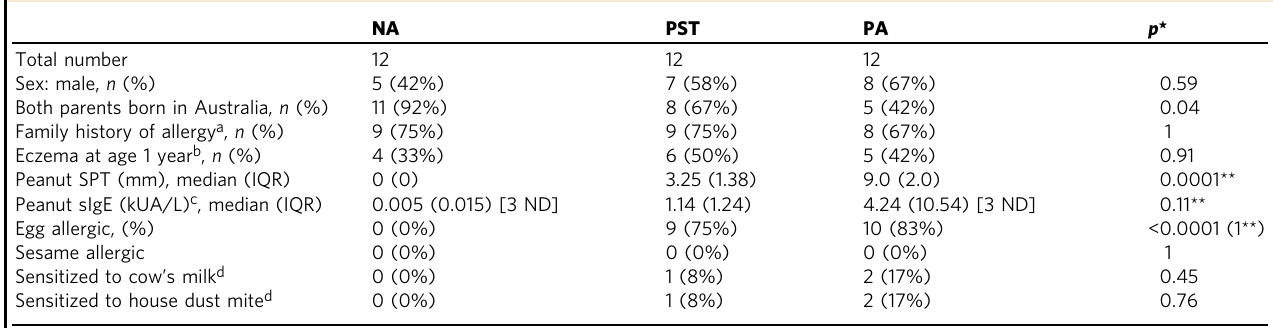
Table 1 Demographics and clinical characteristics of study cohort. NA PST PA p * Total number 12